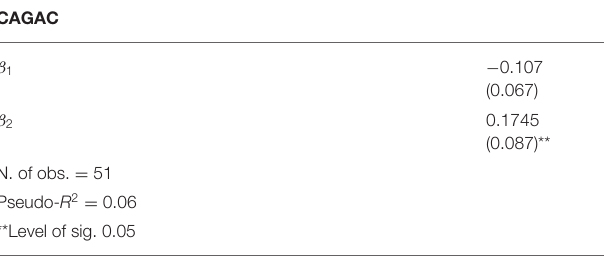
TABLE 2 | Marginal effects ( ◦ C) for tumor type identification.